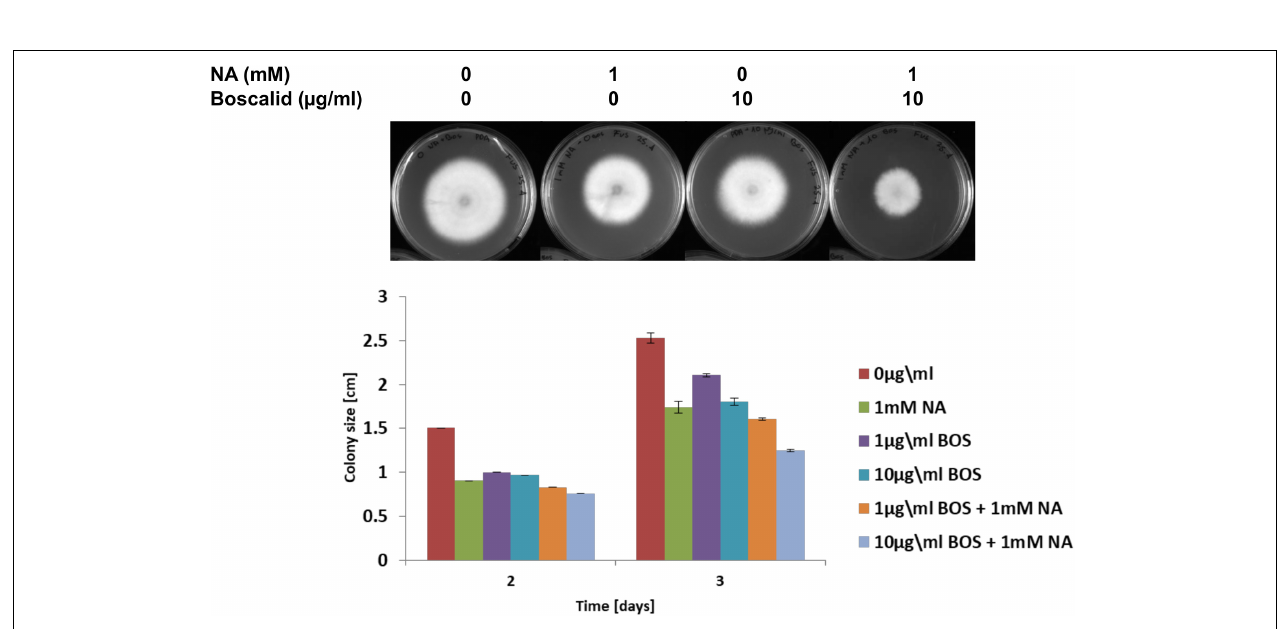
FIGURE 10 | The effect of NA and boscalid on F. oxysporum growth. 1000 conidia were dropped at the center of PDA plates containing the indicated concentrations of NA and boscalid. The surface area of the colony was calculated from its radius.